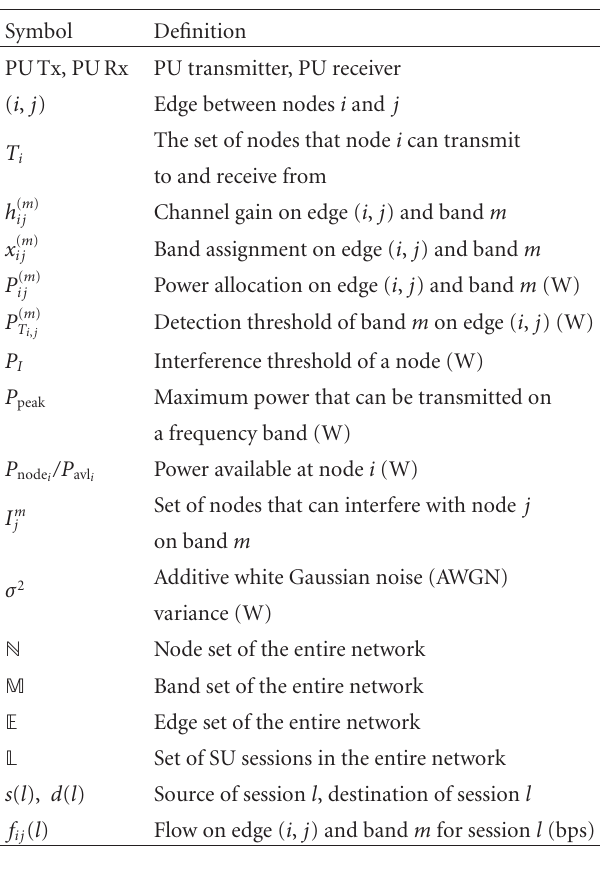
Table 1: Notations.